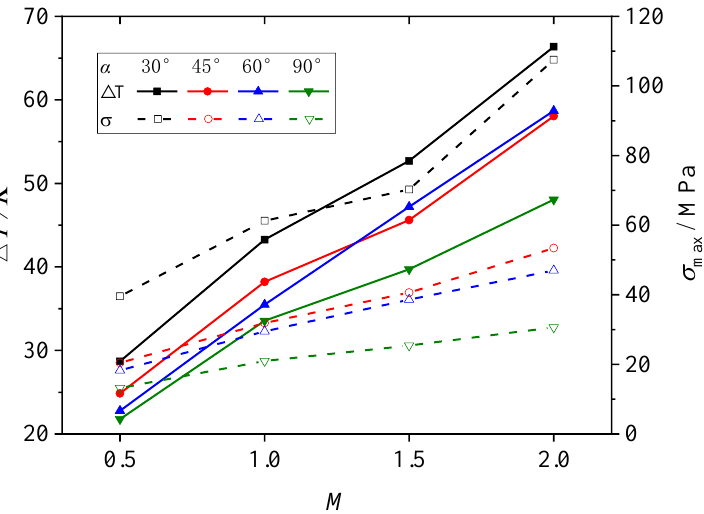
Figure 19. Thermal stress distribution on the leading and trailing paths of the research film hole. ( a ) M = 0.5. ( b ) M = 1.0. ( c ) M = 1.5. ( d ) M = 2.0.